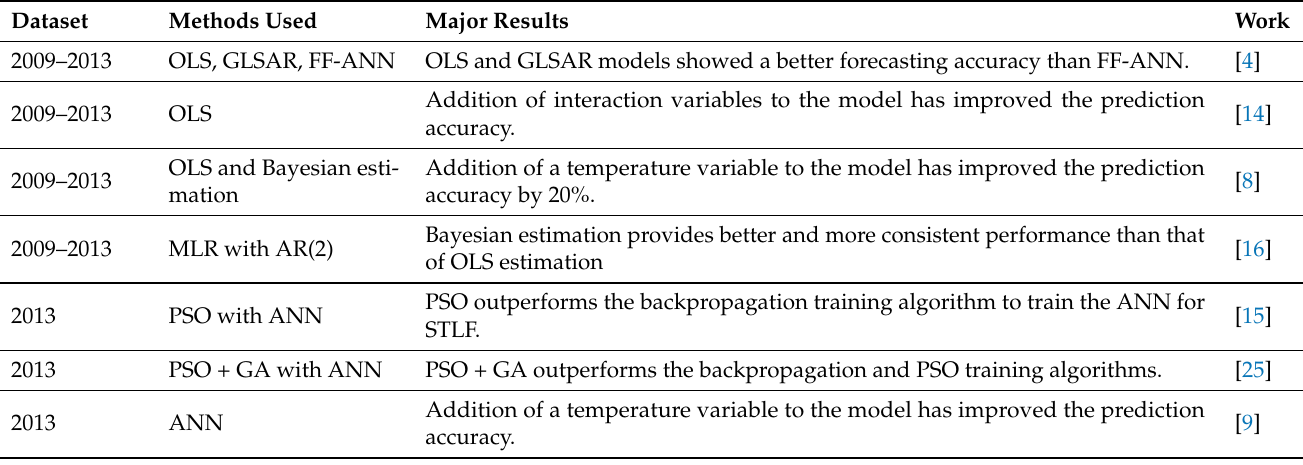
Table 2. A state-of-the-art comparison of recently published related